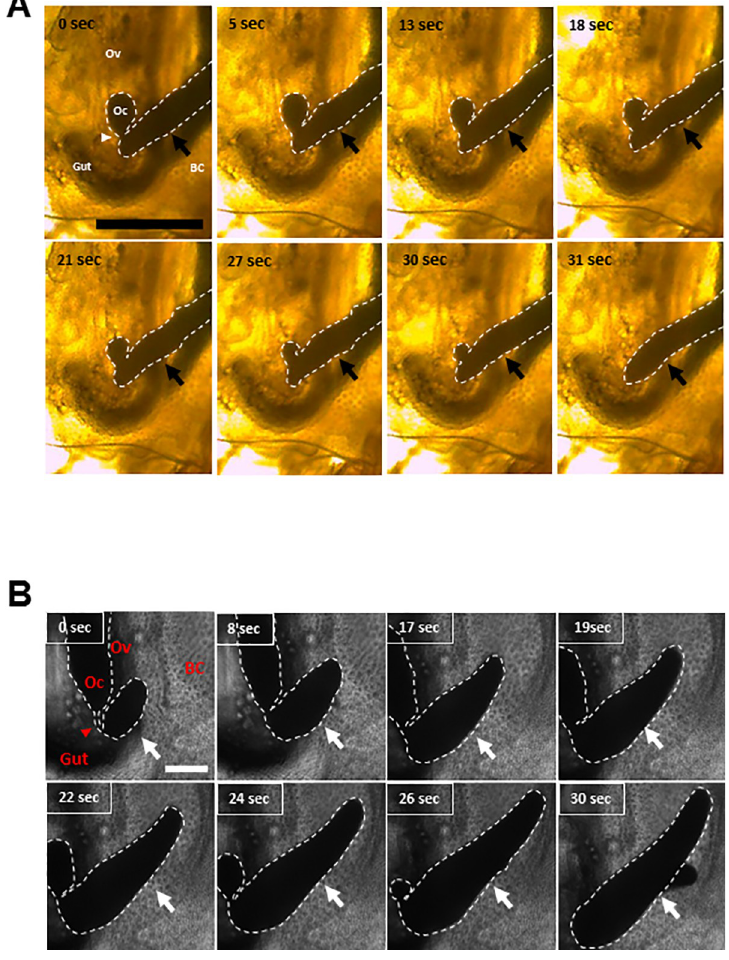
Fig 3. Live images of resting eggs undergoing oviposition in Daphnia magna . The oviposition of resting eggs was observed with a stereo- (A) and a light microscope (B). The dashed line indicates the outline of an ovulating egg. Arrowheads and arrows indicate the egg canal and extruded eggs, respectively. The time lapse after the initial observation is indicated in each panel. Scale bar, 200 μ m. BC, Brood Chamber; Oc, Oocyte; Ov, Ovary. The movie files are deposited as S3 and S4 Movies